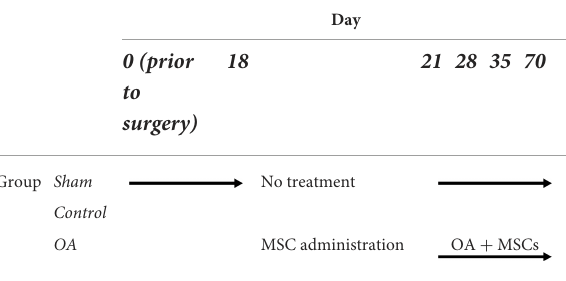
TABLE 1 An overview of experimental groups and the longitudinal time points for SF